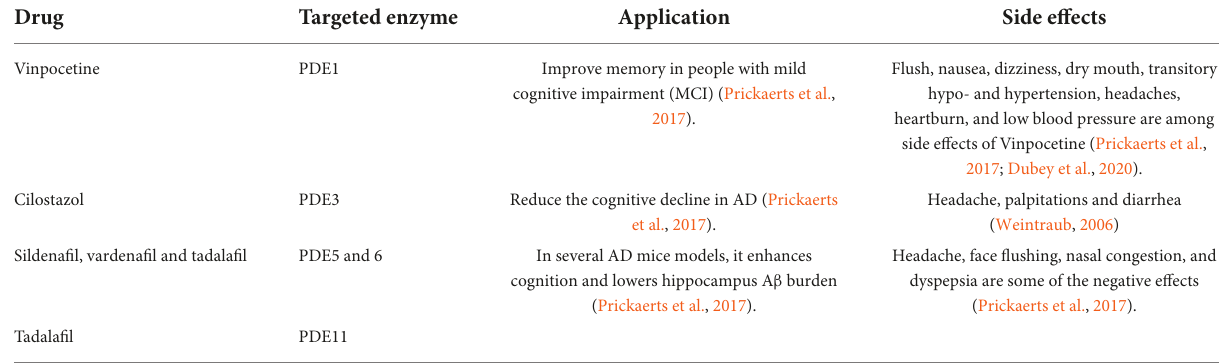
TABLE 2 List of FDA approved drugs as PDE inhibitors with a focus on Alzheimer’s disease.